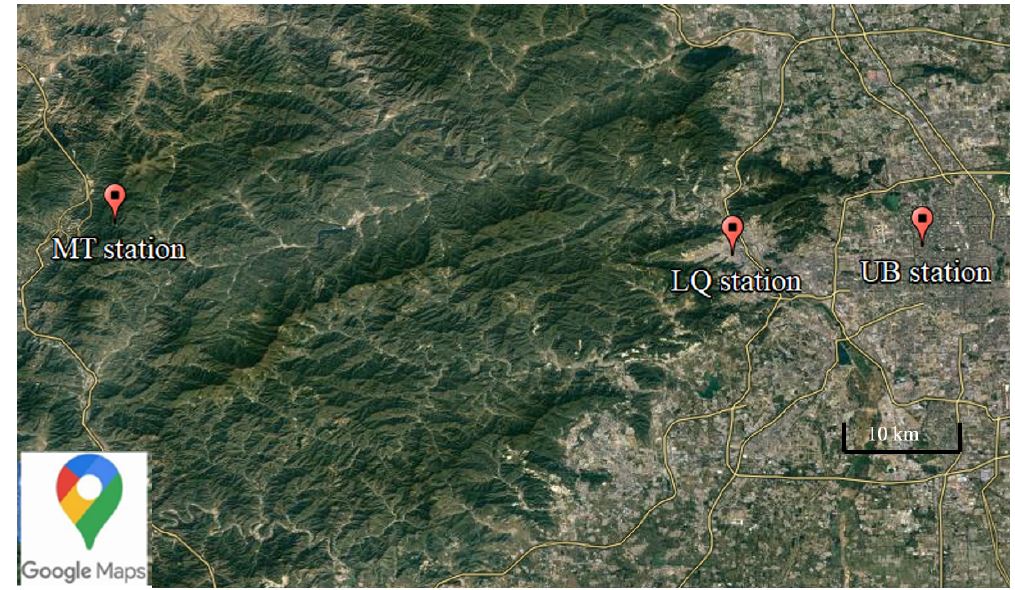
Figure 1. Map showing locations of the urban station (UB), Longquan station (LQ) and the mountain station (MT). Image was produced using © Google